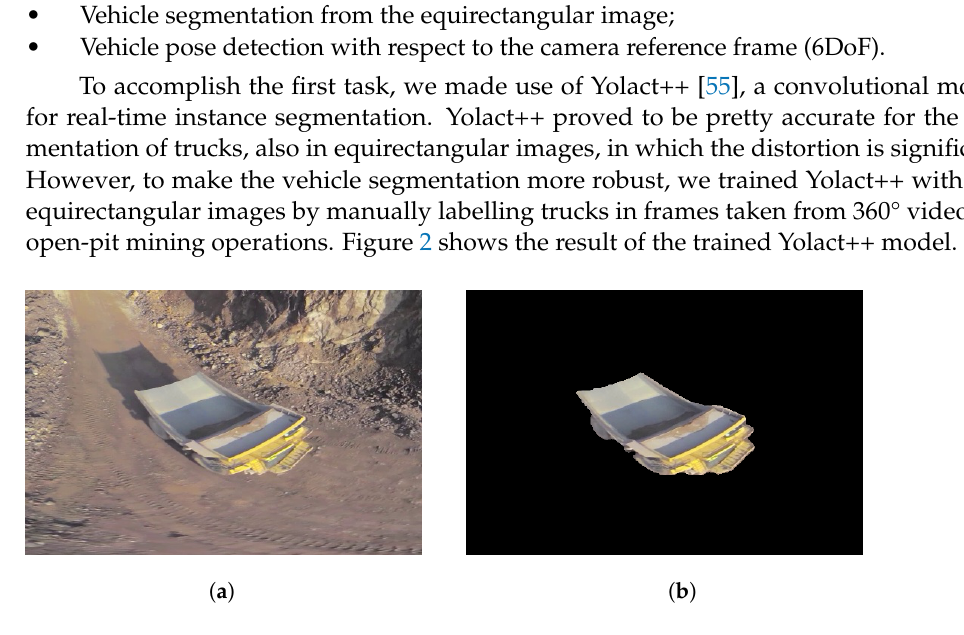
Figure 2. The result of the trained convolutional model Yolact++ for an equirectangular image of a truck. ( a ) An example of an input image showing a truck in a mining environment. ( b ) Result of the segmentation in which the truck is correctly segmented.